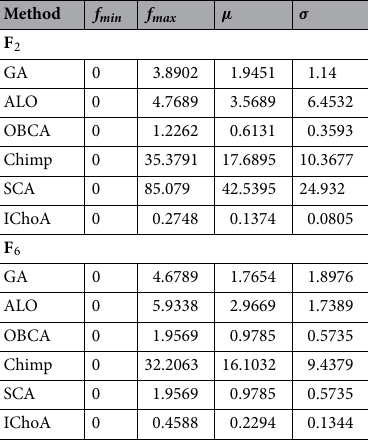
Table 8. Average time consumption outputs of metaheuristics on F 2 and F 6 .